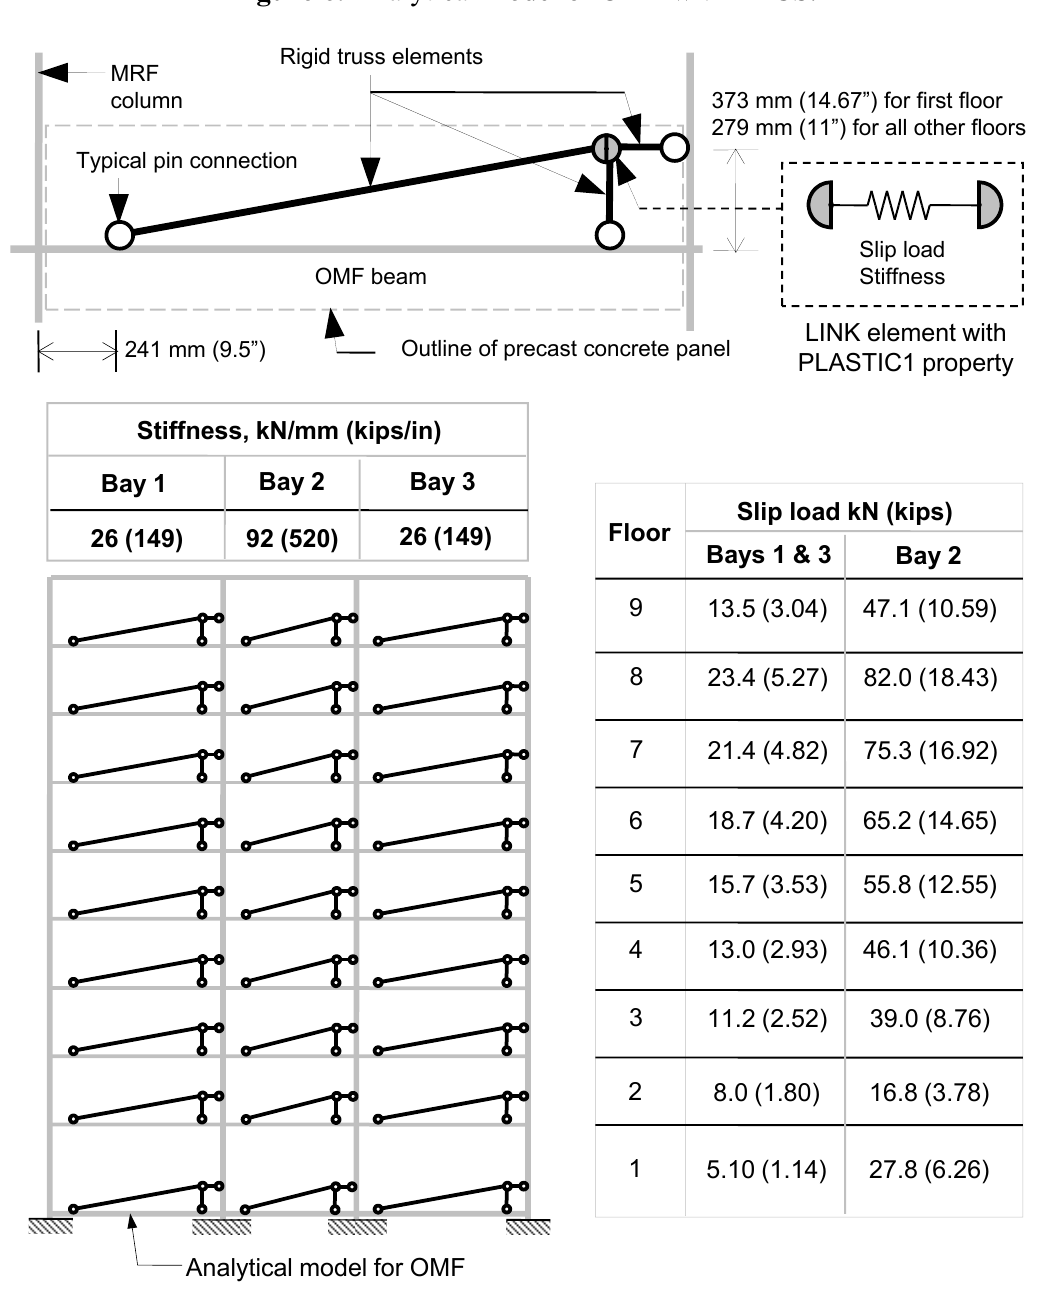
Figure 6. Analytical model of OMF with